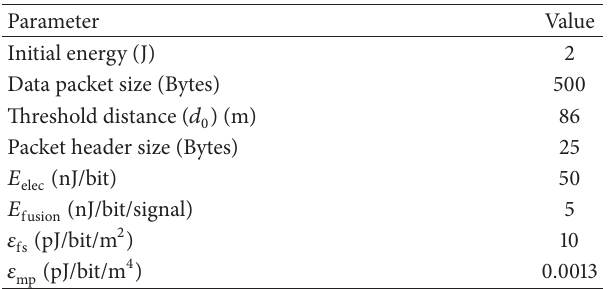
Table 2: Parameters in